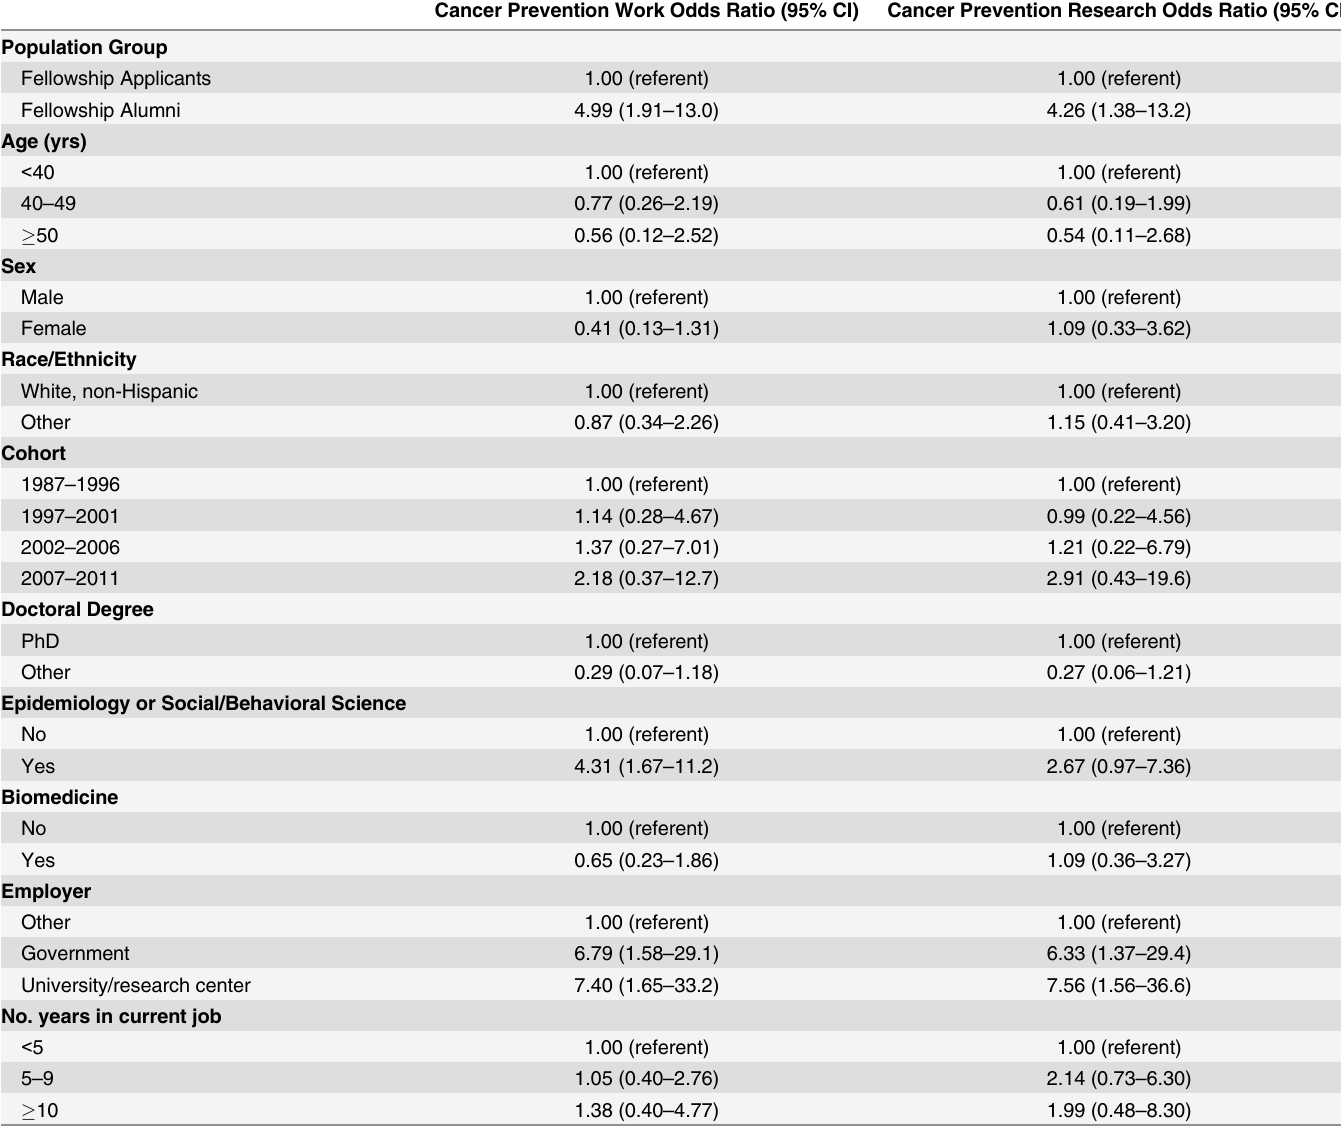
Table 3. Odds Ratios for Factors Associated with the Majority of Current Work Involving Cancer Prevention.